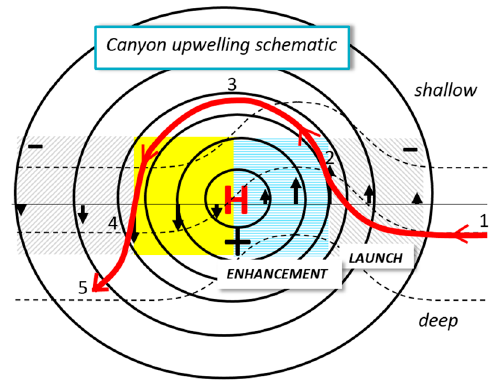
Figure 11. Same as Figure 7, but for the canyon-upwelling scenario. The numbers denote different phases of the process. See text for more details.